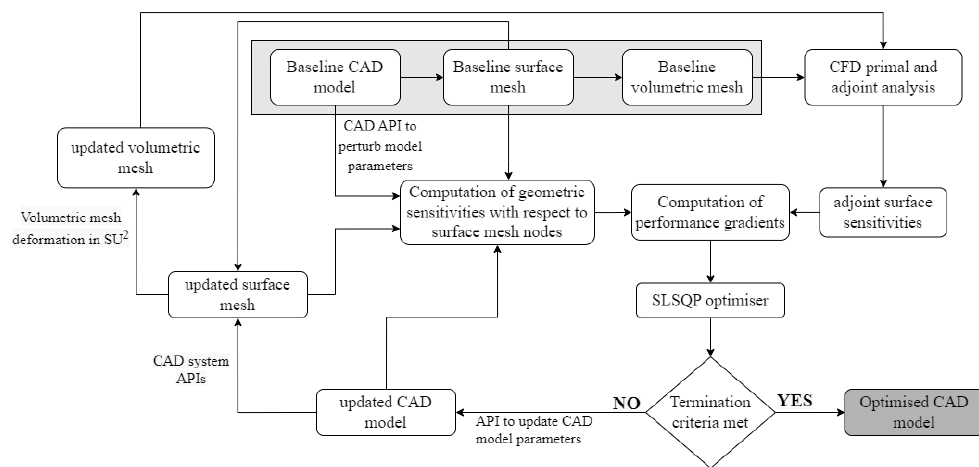
Figure 2. Optimisation